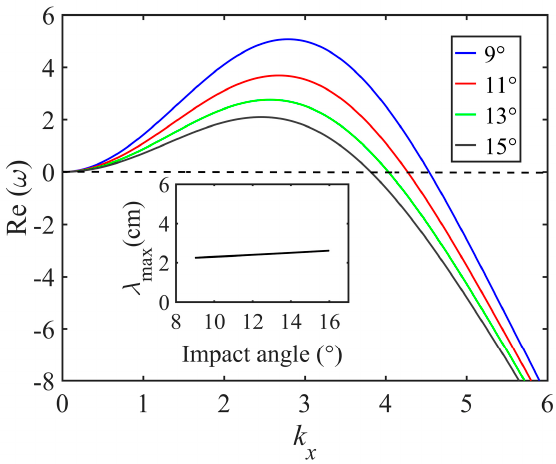
Figure 5. The contour plot of growth rate in the parameter space (cid:3435)(cid:1863) (cid:3051) , (cid:1863) (cid:3052) (cid:3439) for different values of D. ( A ) D = 0. ( B ) D = 0.1. ( C ) D = 1. ( D ) D = 1.5.